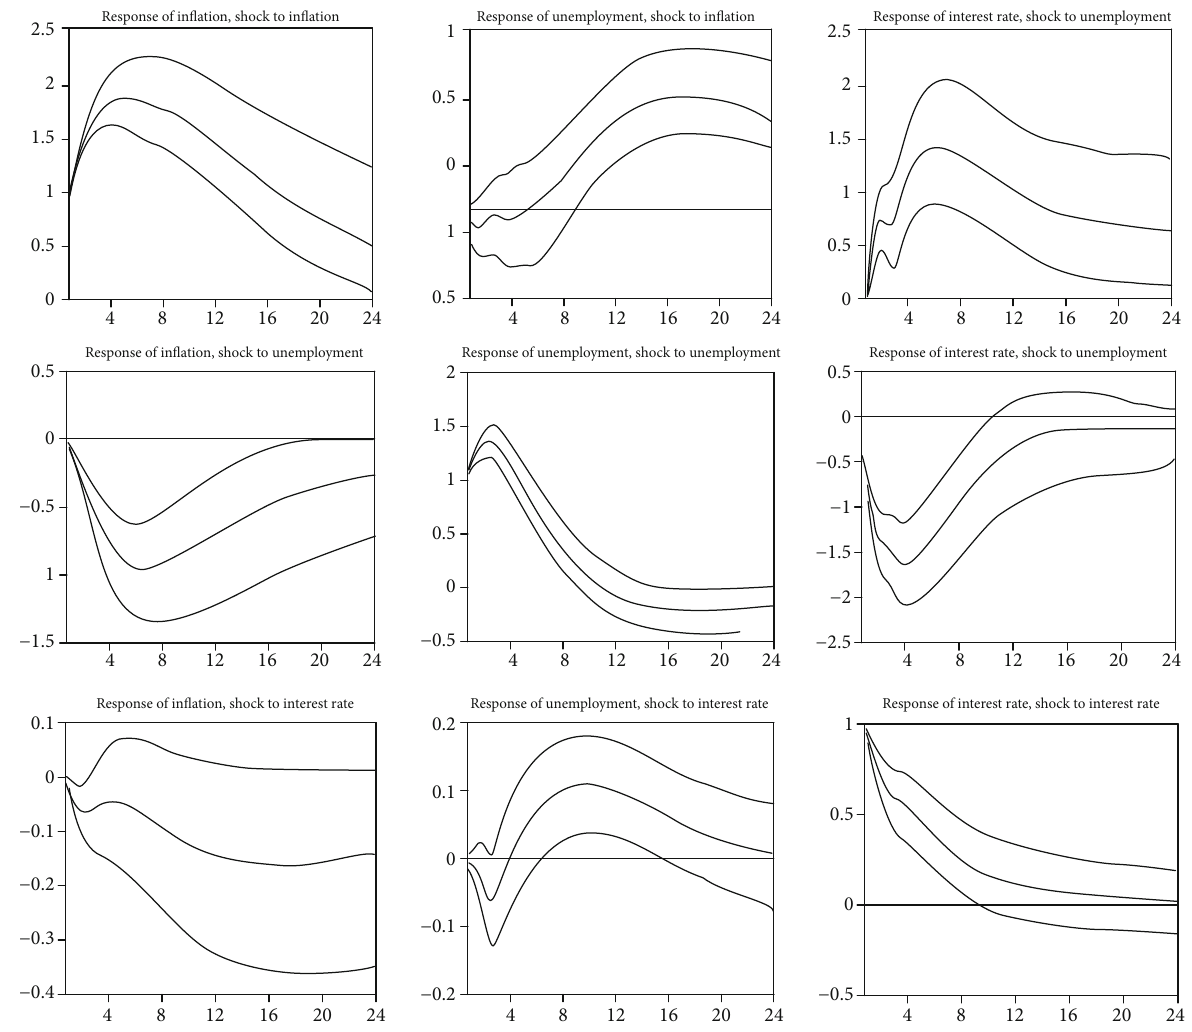
Figure 13: Impulse response functions (this chart comes from Koop and Korobilis